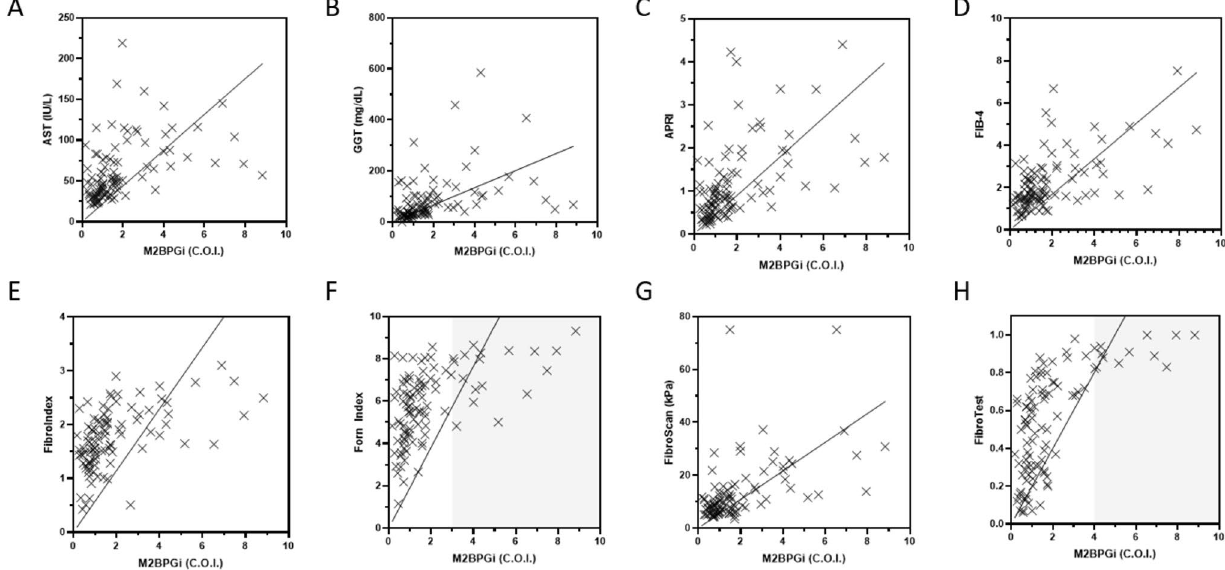
Figure 3. Comparison of M2BPGi levels among other non-invasive measures of liver fibrosis assessment. ( A ) Comparison with AST, ( B ) GGT, ( C ) APRI, ( D ) FIB-4, ( E ) FibroIndex, ( F ) Forns Index, ( G ) Fibroscan and ( H ) Fibrotest. Results showed positive correlations using a Spearman’s rank order